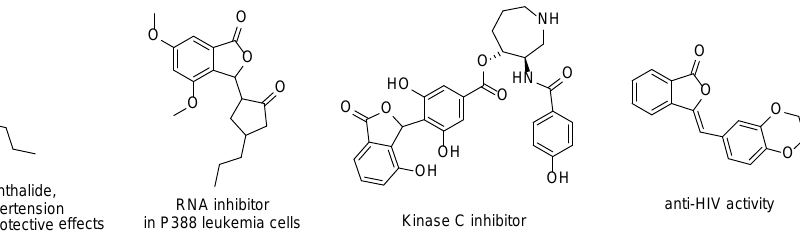
Figure 1. Examples of biologically active phthalides.